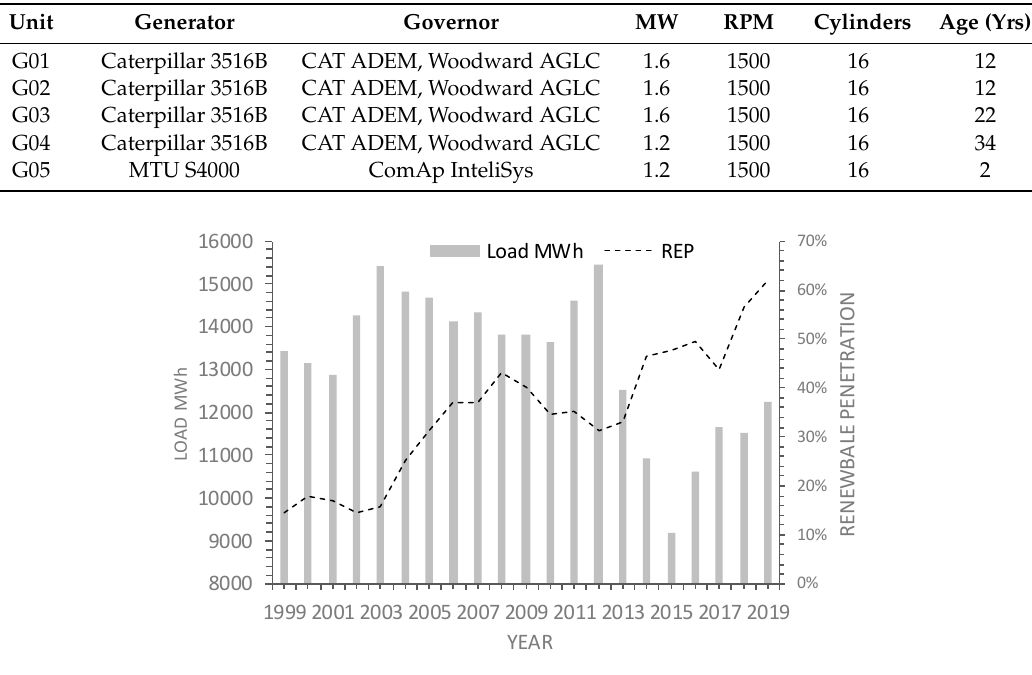
Figure 2. King Island isolated power system performance from 1999 to 2019.